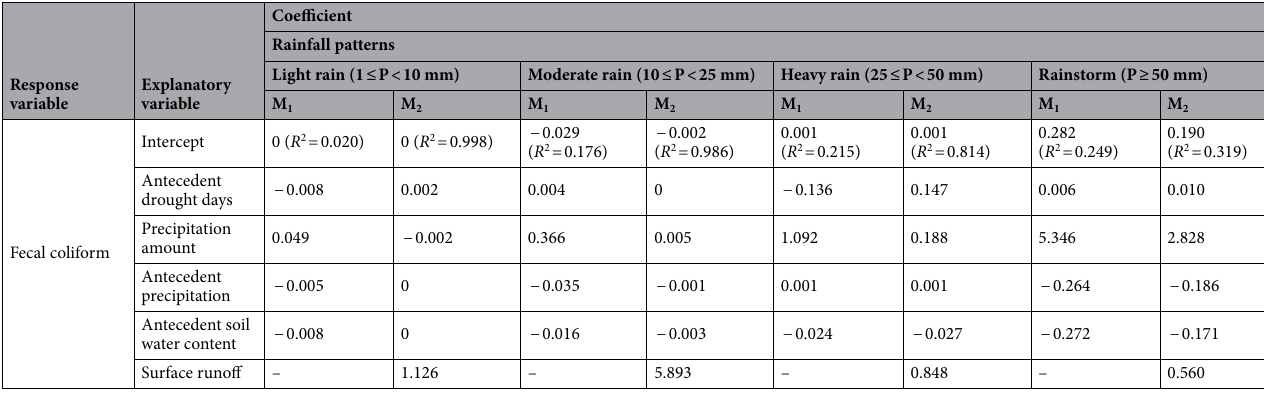
Table 3. Relationship between runoff, ET or pollutant loads with interacting factors, including precipitation amount, antecedent drought days, antecedent precipitation, and antecedent soil water contents under different rainfall patterns (M 1 represents the regression model with explanatory variables excluding runoff, and M 2 represents the regression model that includes runoff as one of the explanatory variables). a R 2 represents the coefficient of determination of the regression models with significance level p < 0.05.